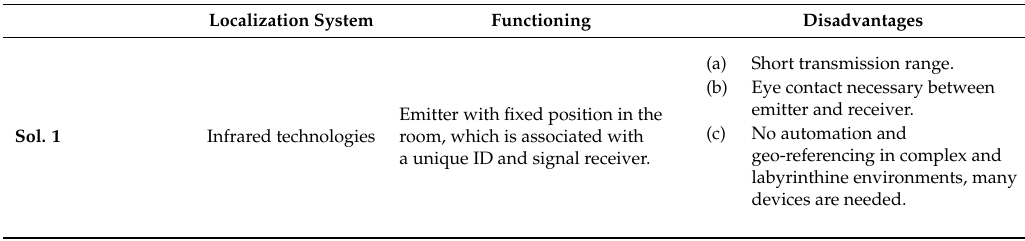
Table 2. Resuming comparison between most used localization systems for indoor